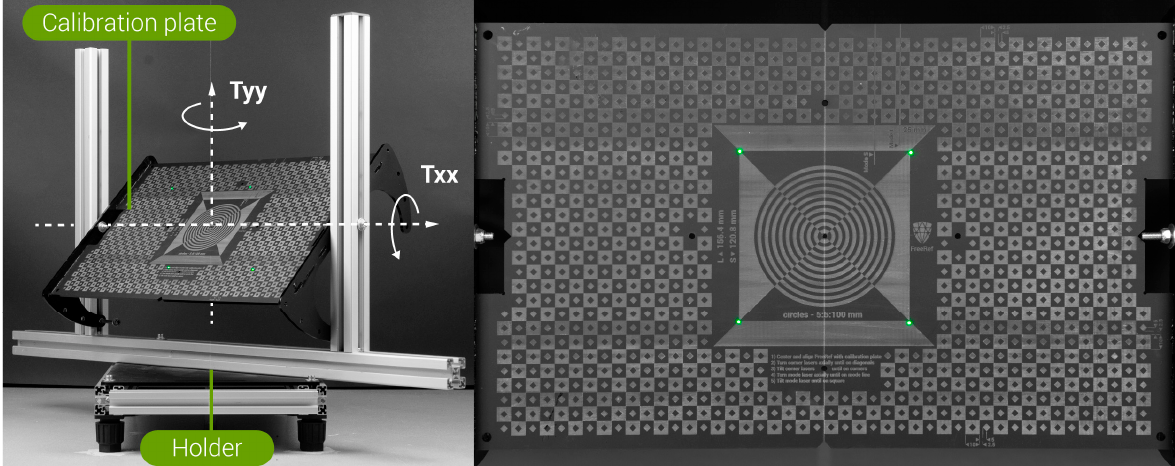
Figure 5. Calibration plate used for the verification tests. ( Left ) The calibration plate in its holder, with the horizontal rotation axis Txx and vertical rotation axis Tyy indicated. ( Right ) Frontal view of the calibration plate.